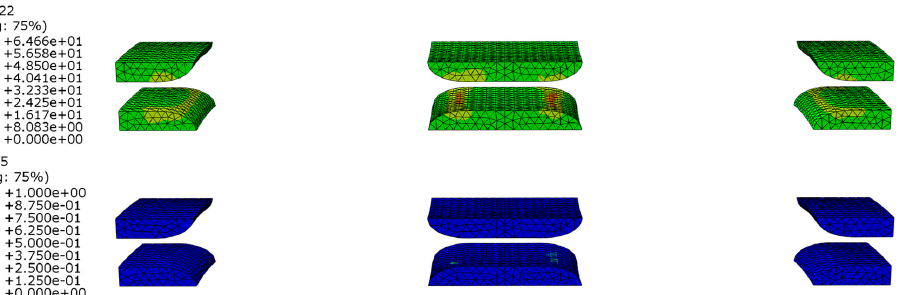
Figure 6. Transverse stress contour ( top , S22) and damage parameter contour ( bottom , denoted by SDV5 for Equation (7)) in weft yarns at a loading strain of 0.58% (ultimate strength).